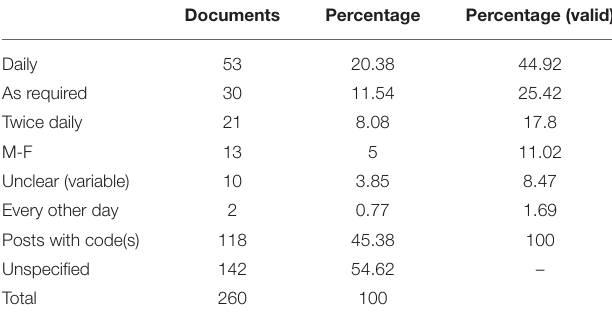
TABLE 4 | Qualitative analysis: dosage